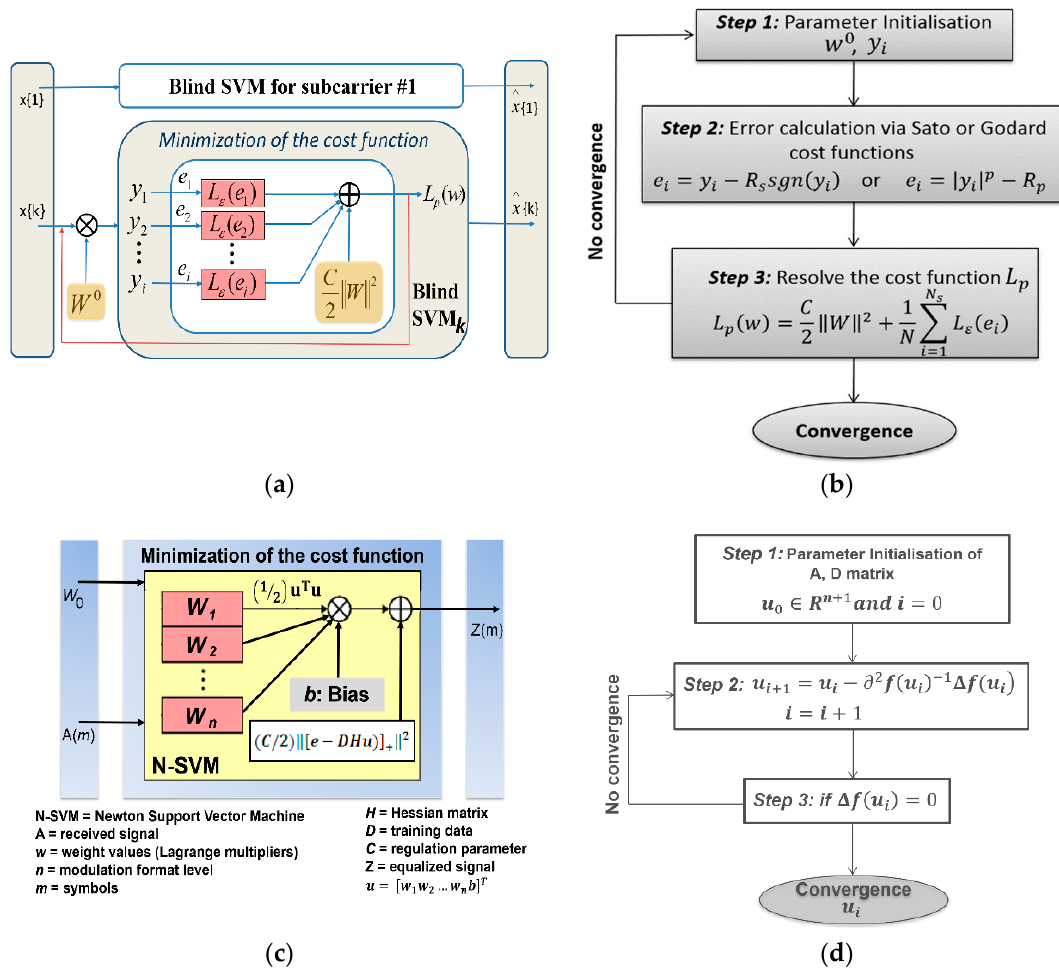
Figure 6. Blind support vector machines (SVMs) (BNLEs): ( a ) Sato/Godard SVM for CO-OFDM and ( b ) its iteratively minimized by re-weighted least squares (IRWLS) pseudocode [31,33]; ( c ) Newton-based SVM and ( d ) the algorithm’s steps [29].